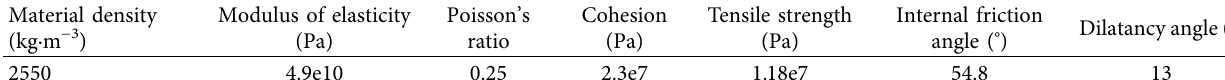
Table 2: Rock mechanical parameters.